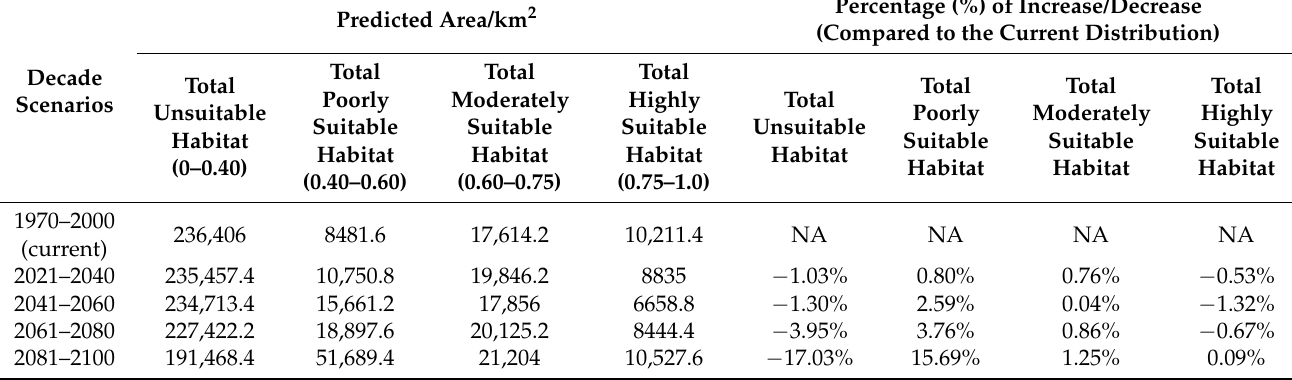
Table 7. Predicted suitable areas for witches’ broom disease of acid lime trees (WBDL) disease (16SrII-B) under current and future climatic conditions.